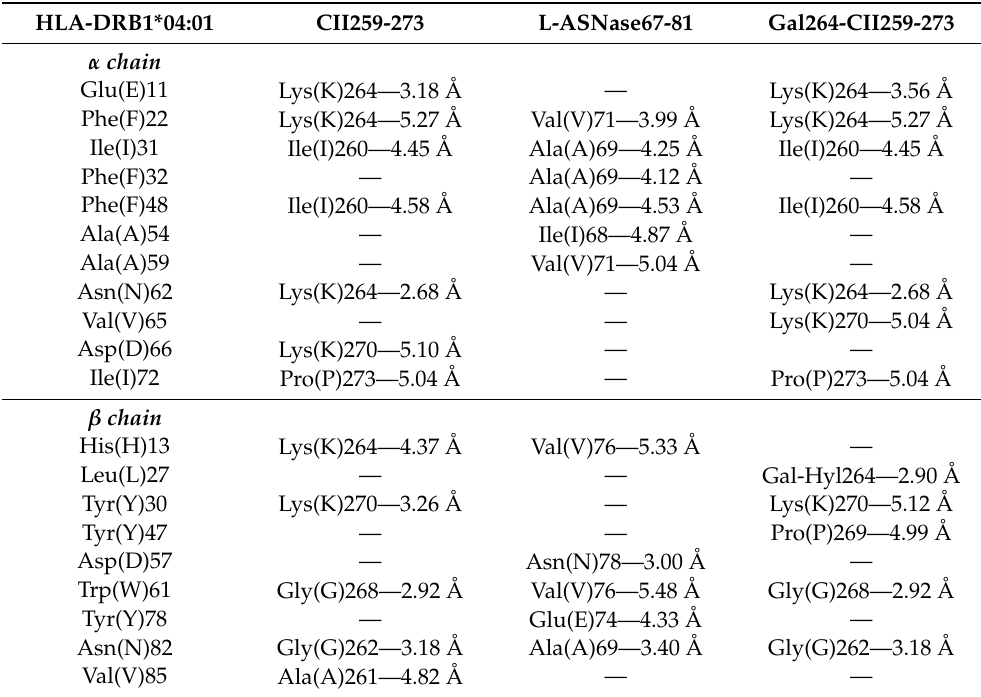
Table 2. Hydrogen bonds between the HLA-DRB1*04:01 molecule and the peptides CII259-273, L-ASNase67-81, and